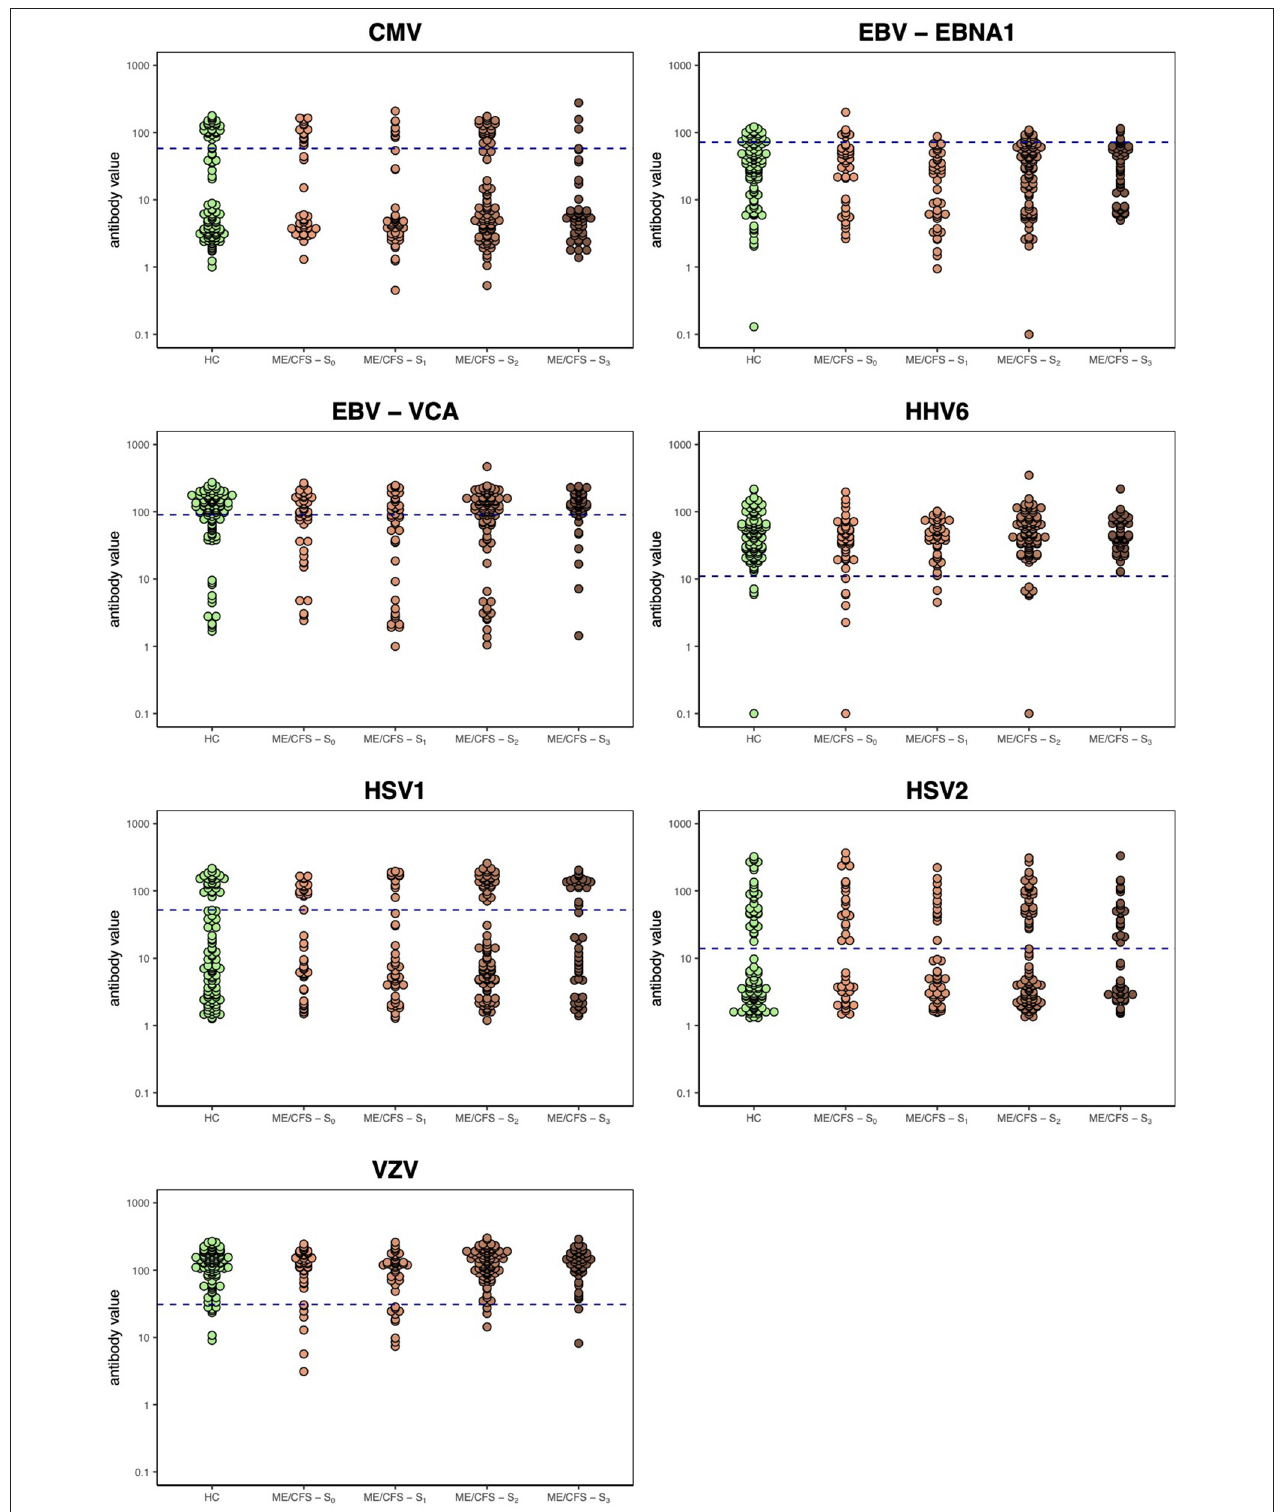
FIGURE 1 | Herpesvirus serology data per study group including the four ME/CFS subgroups. Horizontal dashed lines represent the optimal seropositivity cutoff for the unadjusted analysis according to the maximization of likelihood ratio statistic for testing the significance of the group indicator covariate in the logistic models (see Supplementary Figure 1